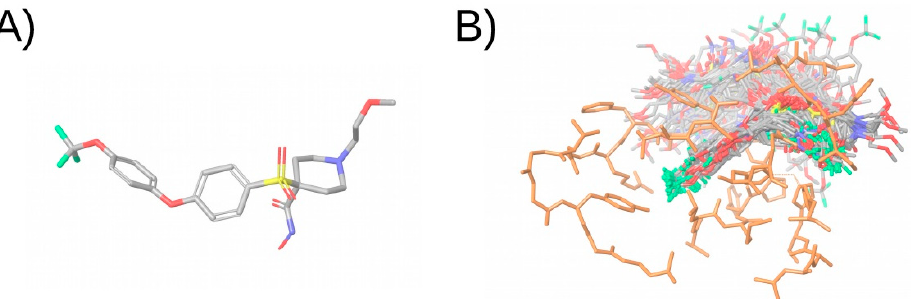
of the protein. The compound is colored in the CPK color scheme and the protein is colored in orange. Non-polar hydrogen atoms have been omitted in the representation. This figure was obtained with Maestro [33].